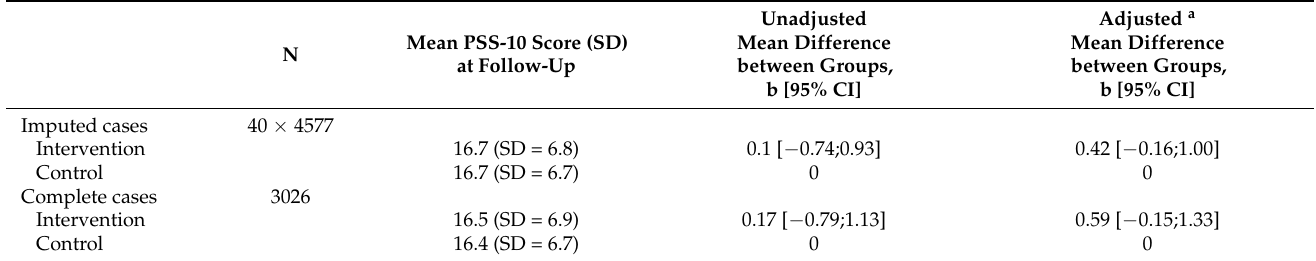
Table 3. Effect of the Healthy High School intervention on perceived stress at 9-month follow-up: analyses of the imputed data set and complete cases.